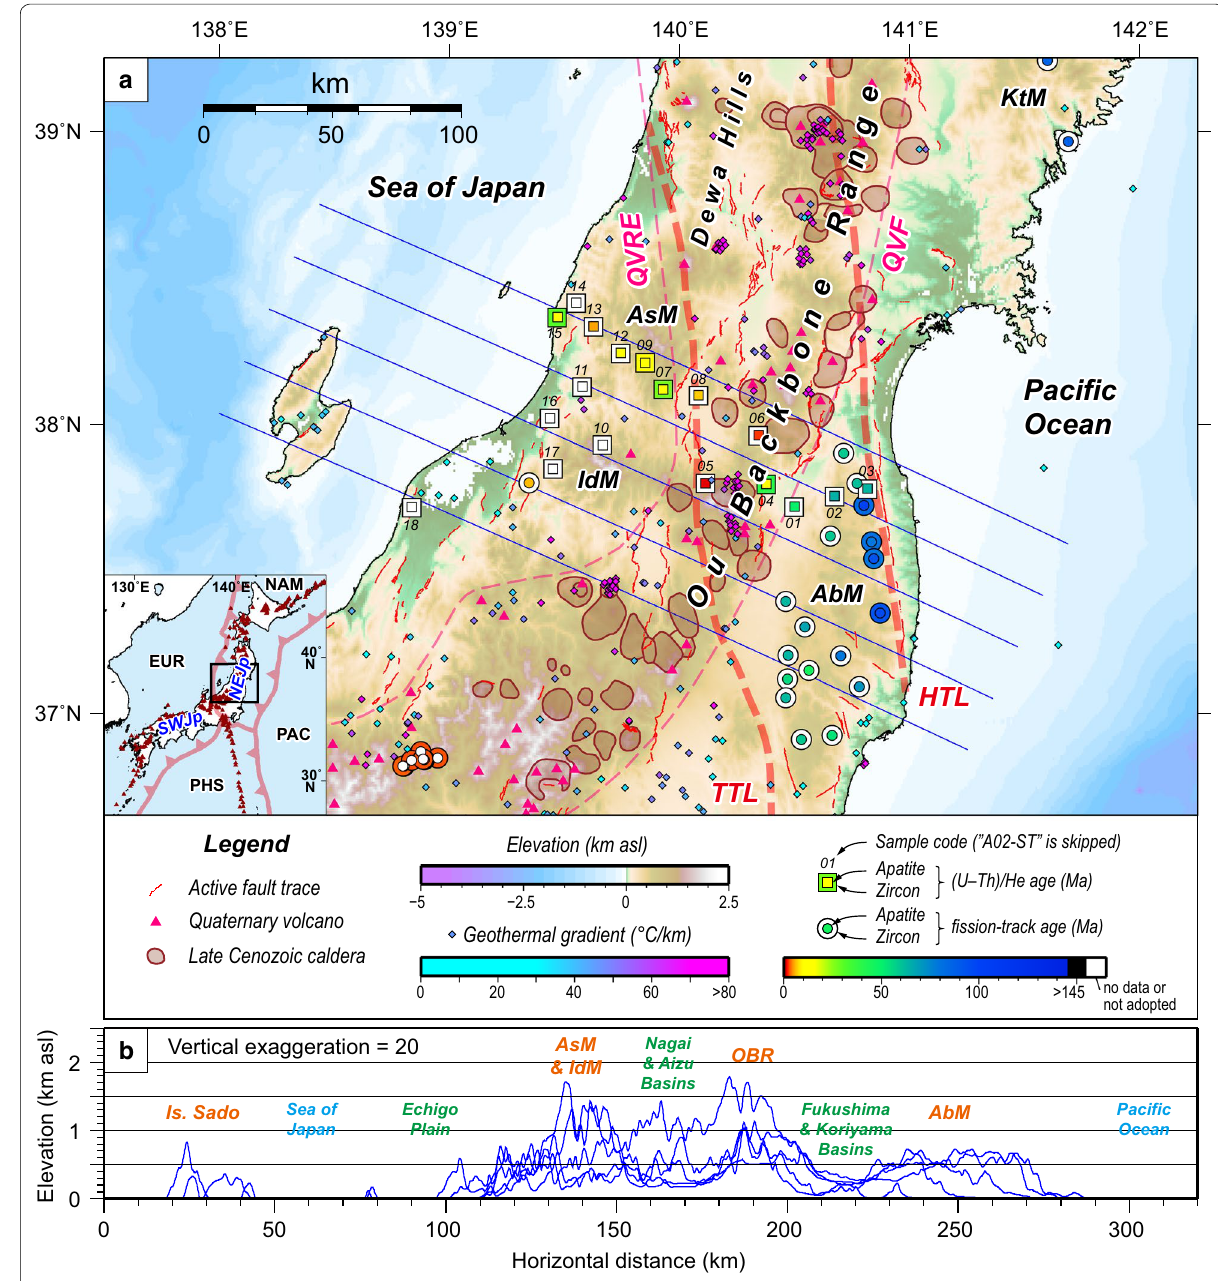
Fig. 1 a Index map of the study area. Active fault traces and Quaternary volcanoes are after Nakata and Imaizumi (2002) and Committee for Cata- log of Quaternary Volcanoes in Japan (1999), respectively. FT ages are from Ohira and Honda (1999), Goto (2001) and Ohtani et al. (2004). This figure was drawn by using Generic Mapping Tools (GMT) (Wessel and Smith 1991) and 30 arc-second grid of the General Bathymetric Chart of the Oceans (GEBCO). b Topographic cross-sections across the study area. The cross-sections were drawn along the blue lines in ( a ). TTL Tanakura Tectonic Line, HTL Hatagawa Tectonic Line, QVF Quaternary volcanic front, QVRE Quaternary volcanic rear edge ( lines are after Yoshida et al. 2013), KtM Kitakami Mountains, AbM Abukuma Mountains, AsM Asahi Mountains, IdM Iide Mountains, EUR Eurasian plate, PAC Pacific plate, PHS Philippine Sea plate, NAM North American